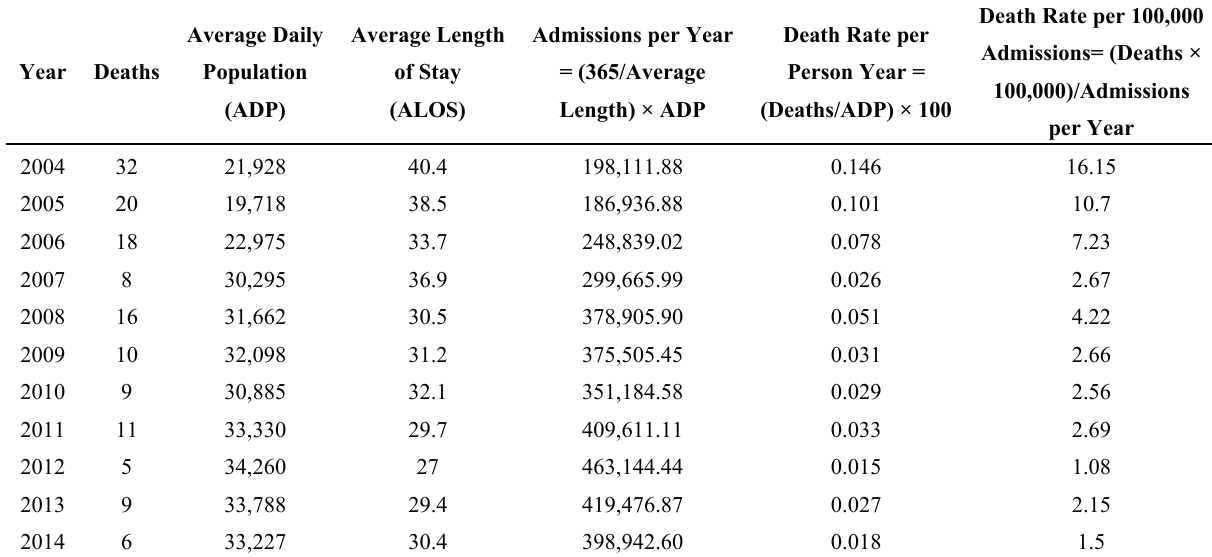
Table 1. Death Rates in U.S. Immigration and Customs Enforcement (ICE) Custody 2004–2014 ( n = 144).